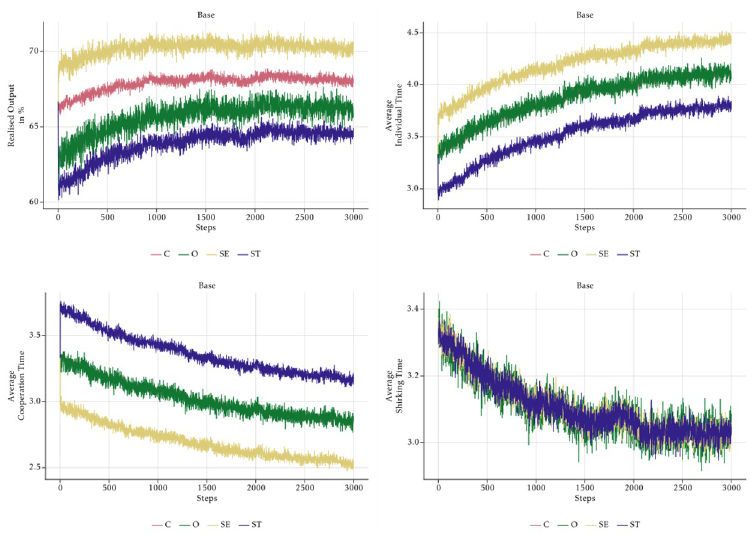
Fig 10. Realised output, average individual, cooperation and shirking time per value-types—Absolute